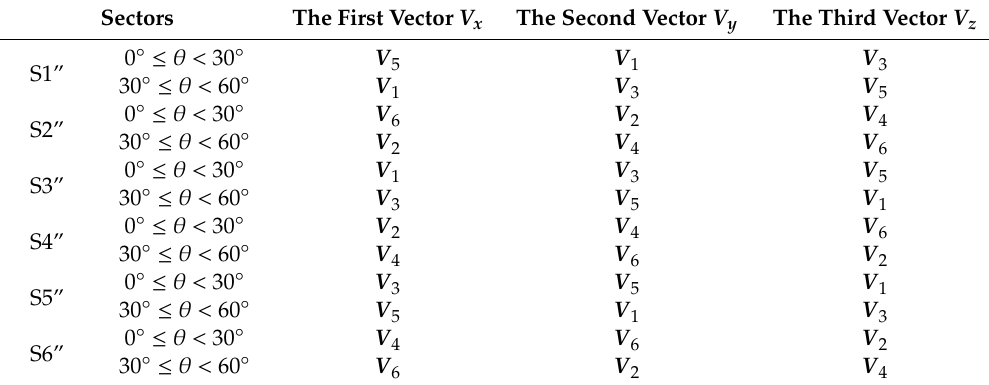
Table 2. Three actuation vectors in each